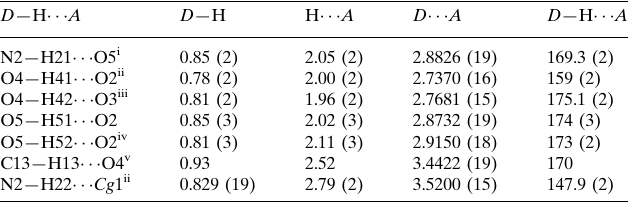
Hydrogen-bond geometry (A˚ , (cid:3) ). Cg 1 is the centroid of the C2–C7